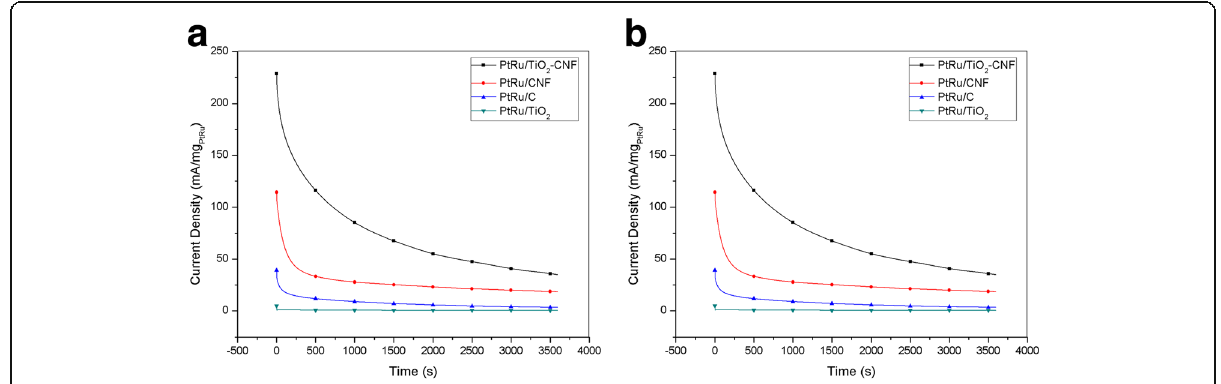
Fig. 7 CA curve at potential of 0.5 V vs Ag/AgCl for PtRu/TiO 2 -CNF, PtRu/C, PtRu/CNF, and PtRu/TiO 2 catalysts